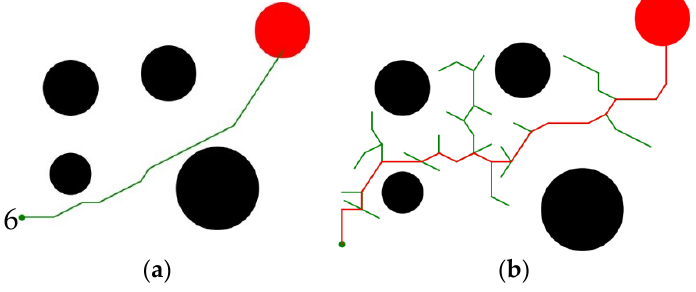
Figure 11. The global path planning results comparison. ( a ) D3RQN, ( b ) RRT.